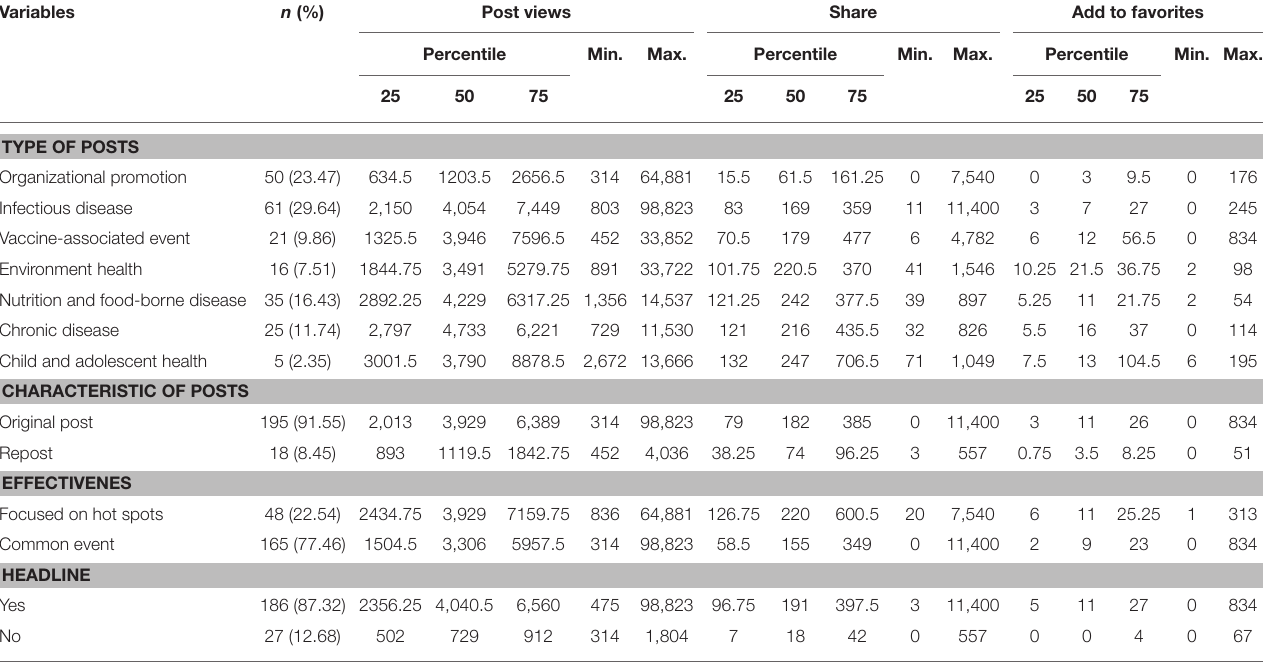
TABLE 1 | Engagement of followers for the posts posted by the Guangzhou CDC I-Health official WeChat account. Variables